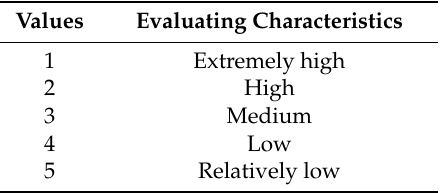
Table 3. Level of similarity and their evaluating